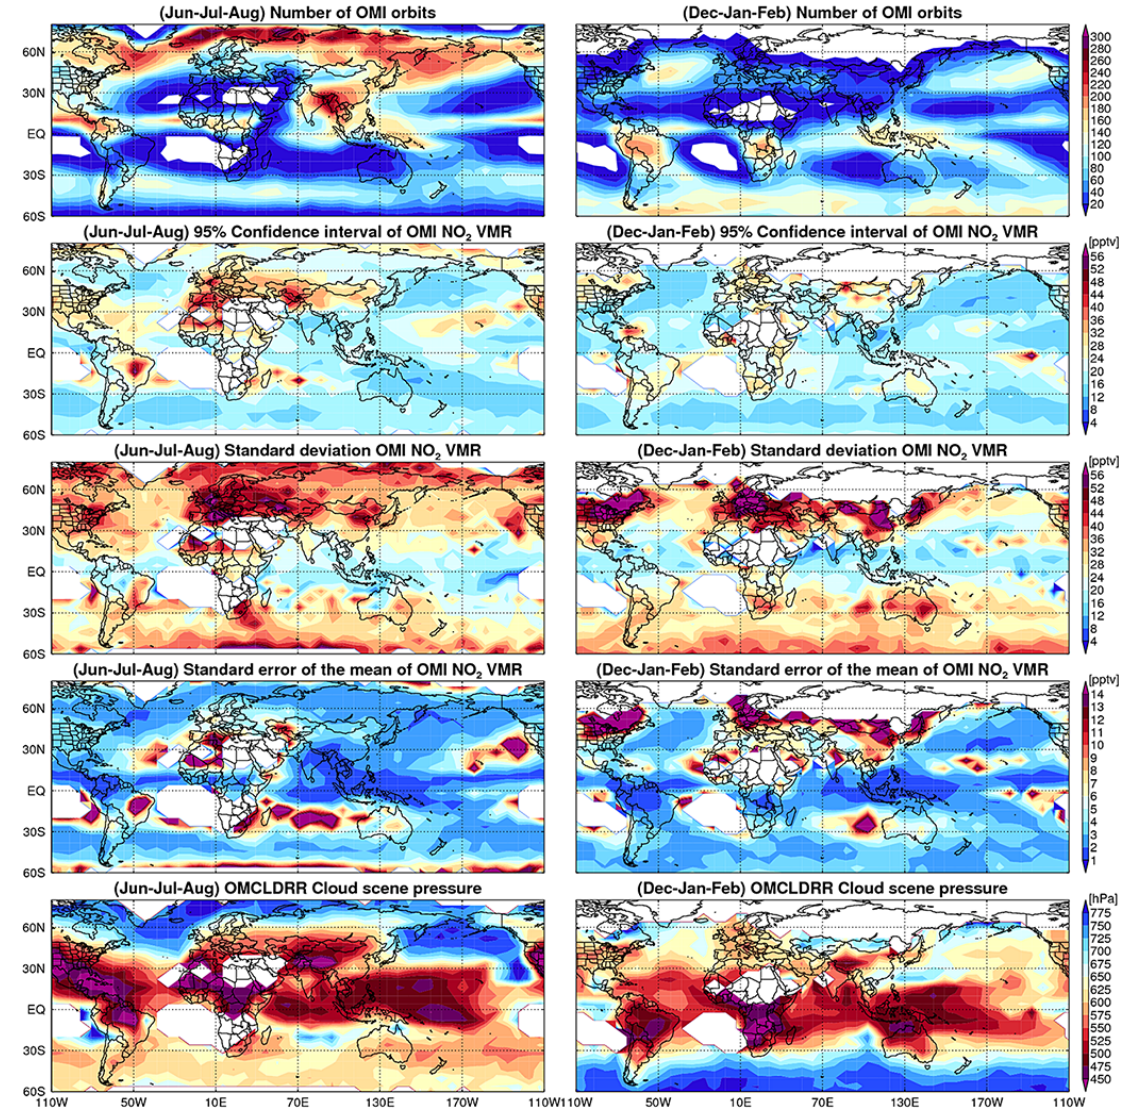
Figure C1. Left: June–August and right: December–February averages over 2005–2007: first row: number of OMI overpasses used to derive